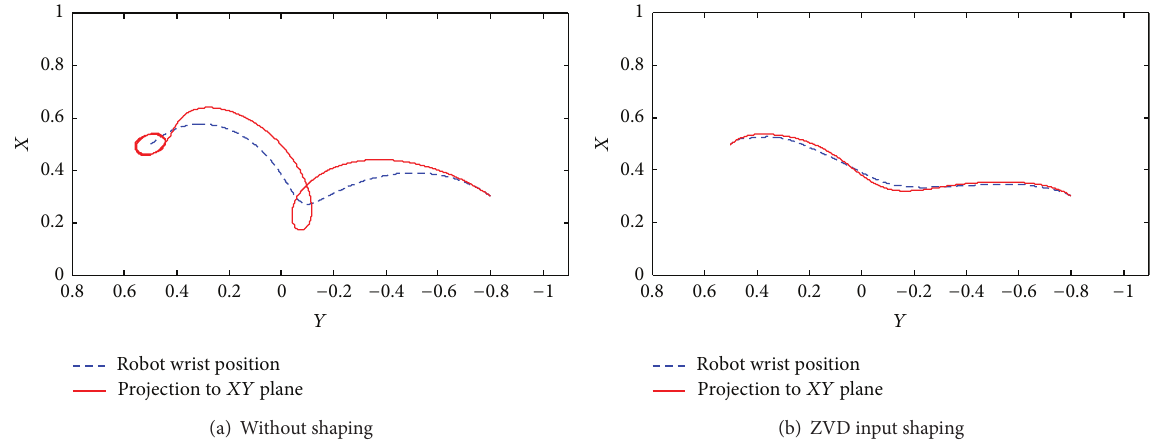
Figure 10: Projection of pendulum bob position in XY plane: (a) without shaping (b) with ZVD shaping.